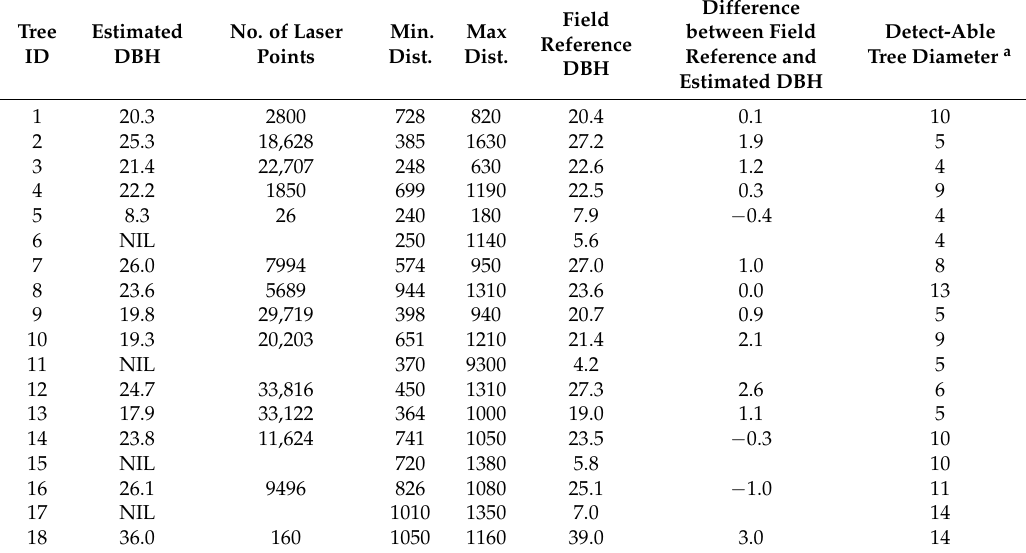
Table 2. Summary at the individual tree level: Estimated DBH, the number of laser points used for detection. The minimum (Min. dist.) and maximum (Max dist.) observed distance to the tree, and field measured DBH. Minimum detectable tree diameter calculated for each tree. All distances are given in cm.